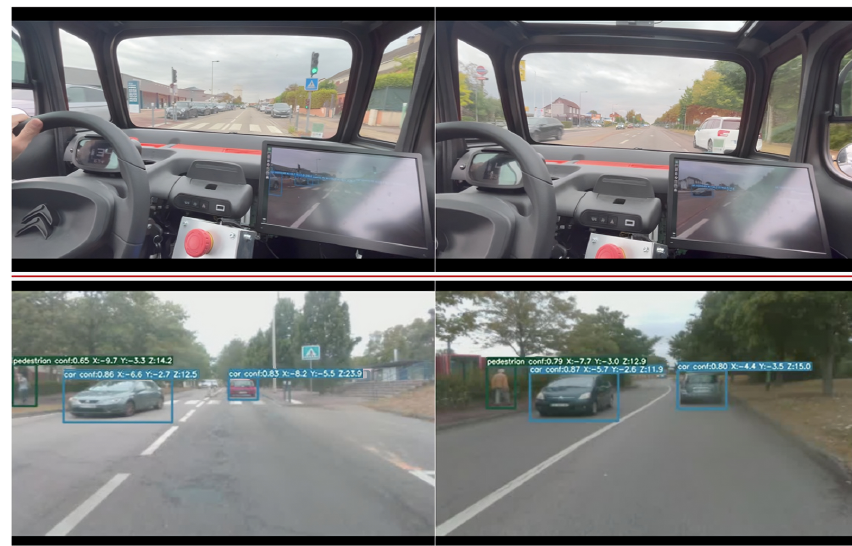
Figure 7. The algorithm tested in real-time conditions on an embedded